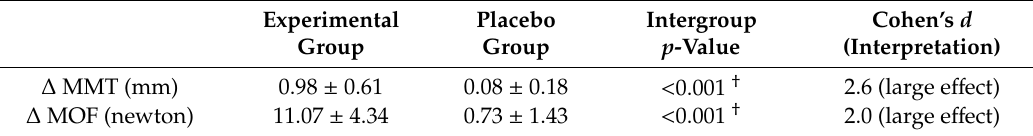
Table 3. Comparison of amount of change in each group. Experimental Placebo Group Group